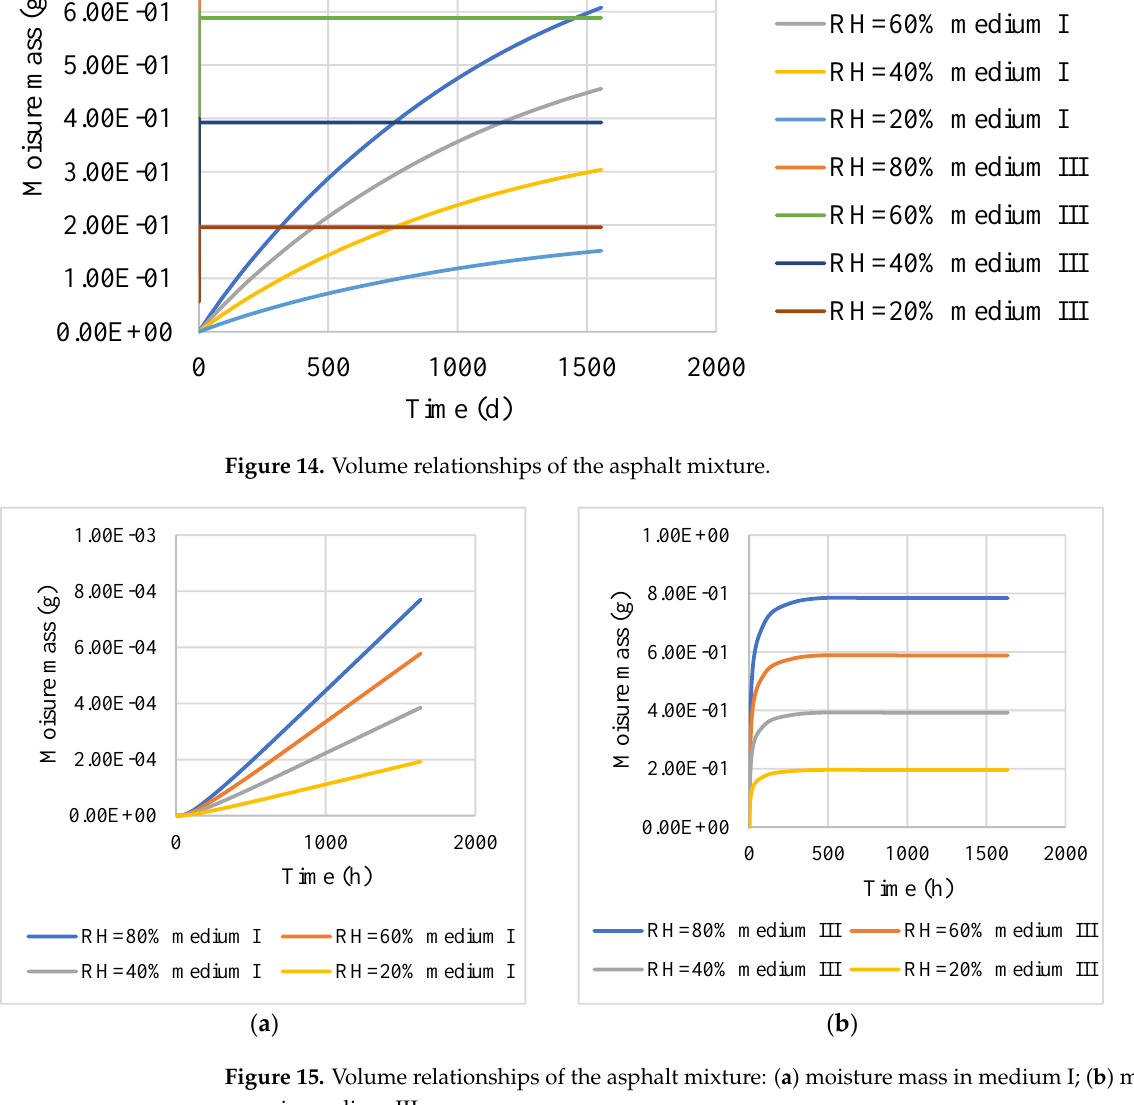
Figure 15. Volume relationships of the asphalt mixture: ( a ) moisture mass in medium I; ( b ) moisture mass in medium III.